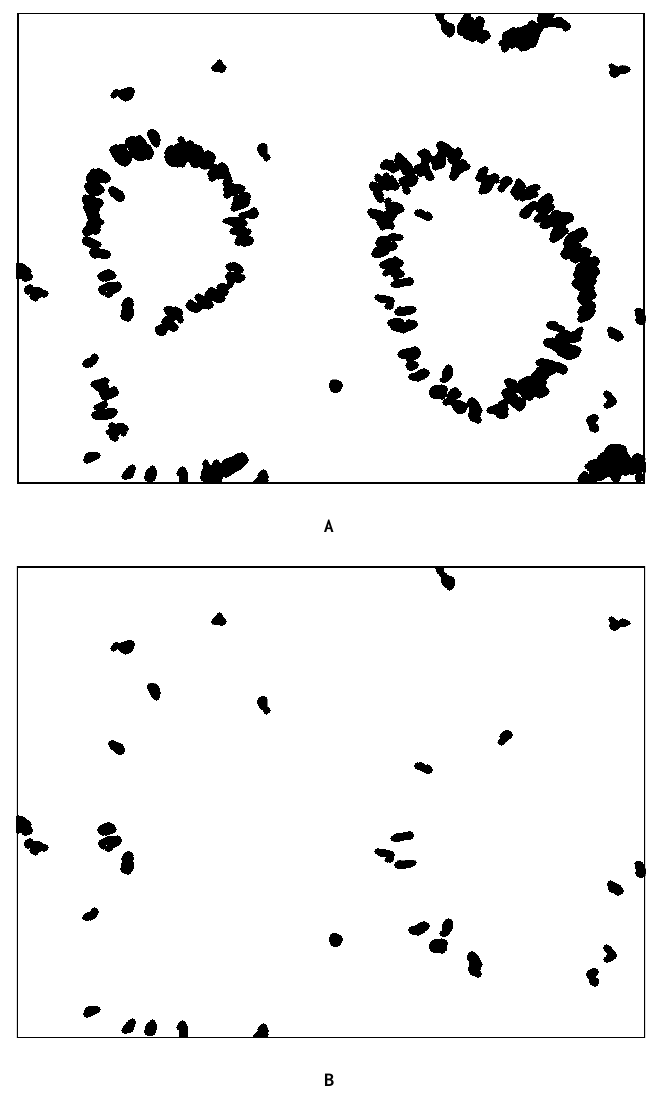
FIGURE 4. Extraction of detached regions as representative of average goblet cell nuclei in size. (A) Small-sized nongoblet cells removed first; (B) retaining the isolated single cells after the attached cells being removed from